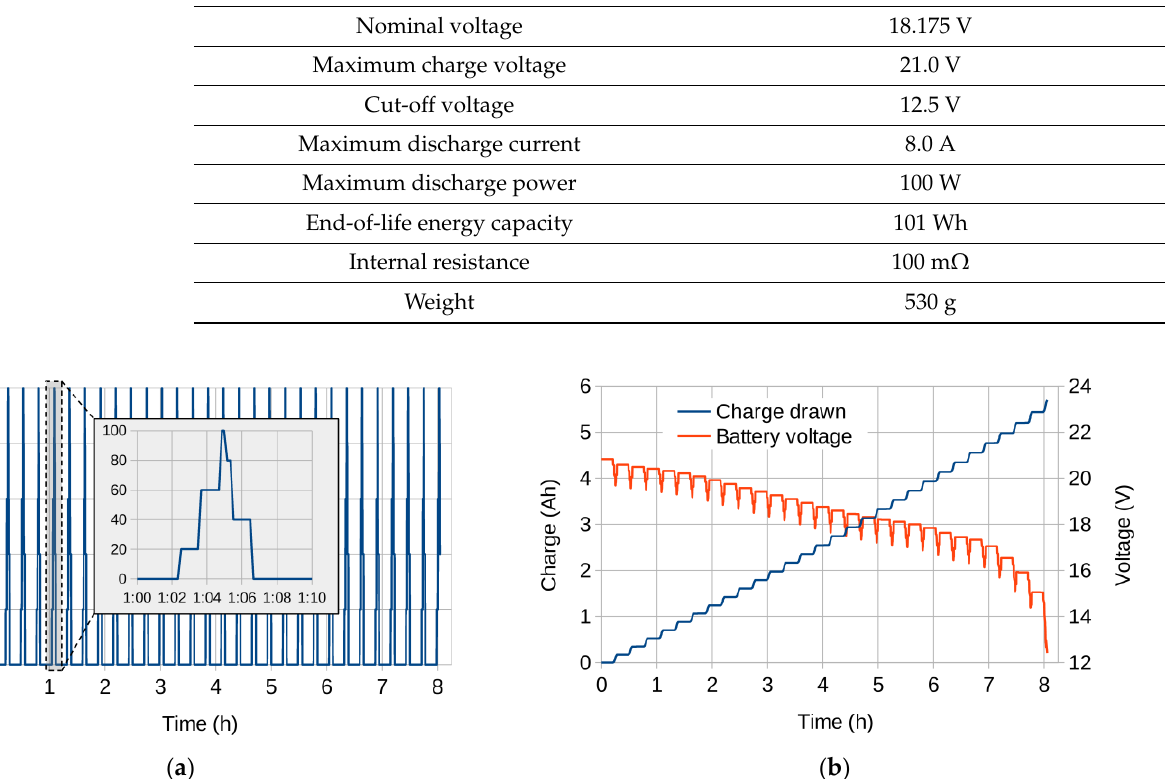
Table 4. Battery pack parameters.